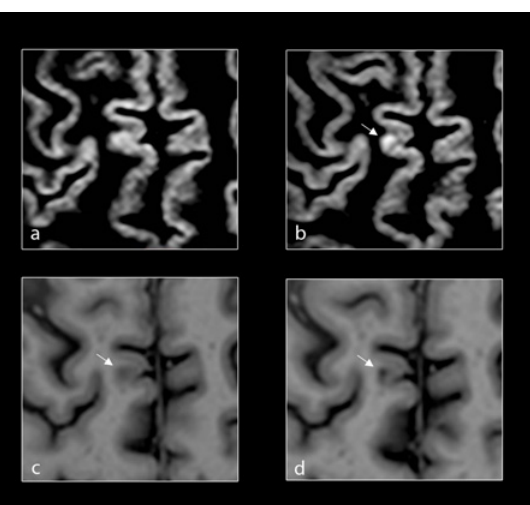
Fig 2. Reclassification of new cortical lesions. Baseline and follow up axial DIR (a, b) of the brain of a patient with primary progressive multiple sclerosis (PPMS) demonstrating a new focal lesion in the cortical grey matter (white-arrows) at follow-up. Corresponding baseline and follow-up axial PSIR (c, d) of the same patient with PPMS demonstrating focal lesions in the cortical grey matter (white-arrows) at both baseline and